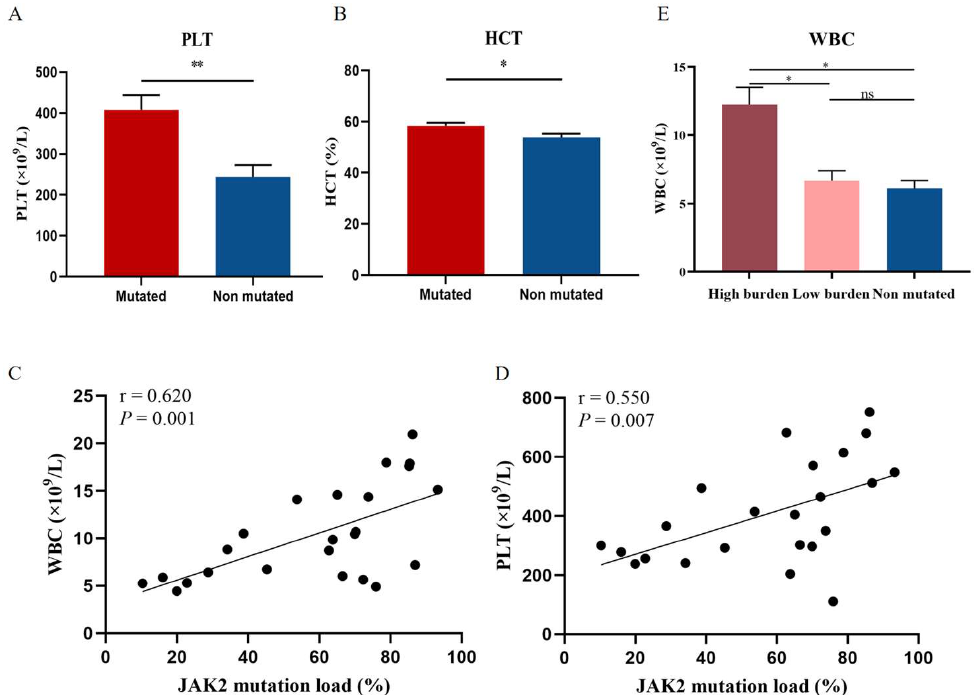
Figure 3. Correlation of JAK2 mutations and mutational burden with blood cell counts. Levels of PLT ( A ) and HCT ( B ) in JAK2-mutated patients compared with non-JAK2-mutated patients. ( E ) WBC levels in JAK2 high mutational burden, low burden, and unmutated groups. Mean value ± standard error of the mean (SEM). Mann–Whitney U test, * p < 0.05, ** p < 0.01, ns: no significance ( p > 0.05). Scatter plot of the correlation between WBC ( C ) and PLT ( D ) levels and JAK2 mutational burden. Spearman’s correlation test.